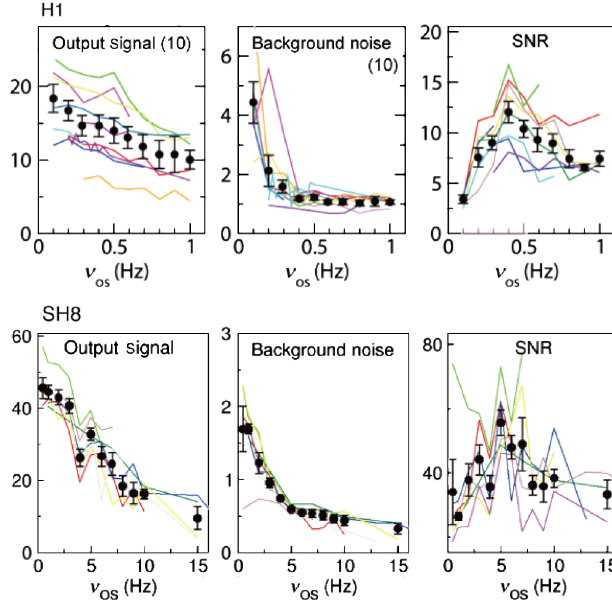
FIG. 6. Molecular variability of the measured responses (H1, SH8). Results are for the OS, BN, and SNR for different molecules. Units: OS ( nm 2 ), BN ( nm 2 = Hz ), SNR (Hz). The error bars represent the standard error over different